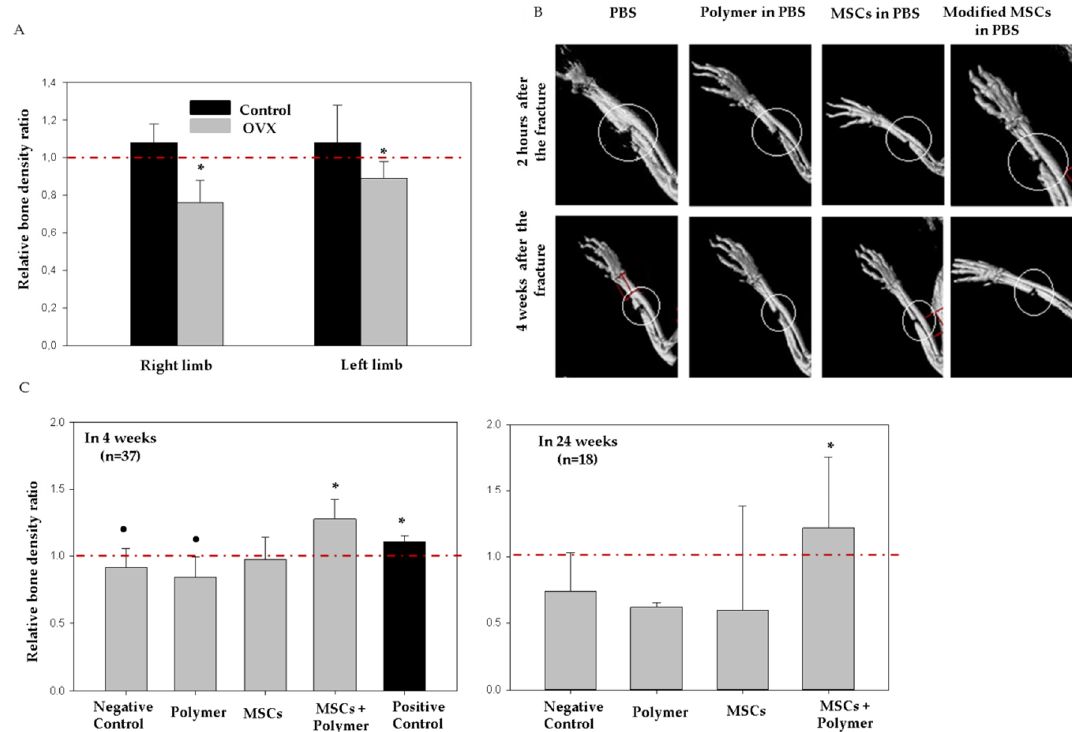
Figure 5. Bone density measurements and representative micro-CT images of the ulna fracture. ( A ) Osteoporosis rat model: bone density analysis in 5 control (no OVX) and 20 OVX animals; data are presented as the ratio of the final bone density (3 months) to the initial (before surgery); data are presented as the mean ± SD, * p ≤ 0.05 compared to the control (unpaired t -test); ( B ) the representative microCT images of the rat extremities after 2 h and 4 weeks post-surgery (In Vivo Imaging System, Caliper, USA); and ( C ) the bone density in the regions of the ulna fractures: data are presented as a proportion of final bone density (4 or 24 weeks after surgery) to the initial (2 h after surgery); the data are presented as the median (IQR 0.25–0.75), * p ≤ 0.05 compared to a negative control, • p ≤ 0.05—compared to a positive control (pairwise comparison using Mann–Whitney Rank Sum Test). Bone density was measured using microFCT IVIS Spectrum.